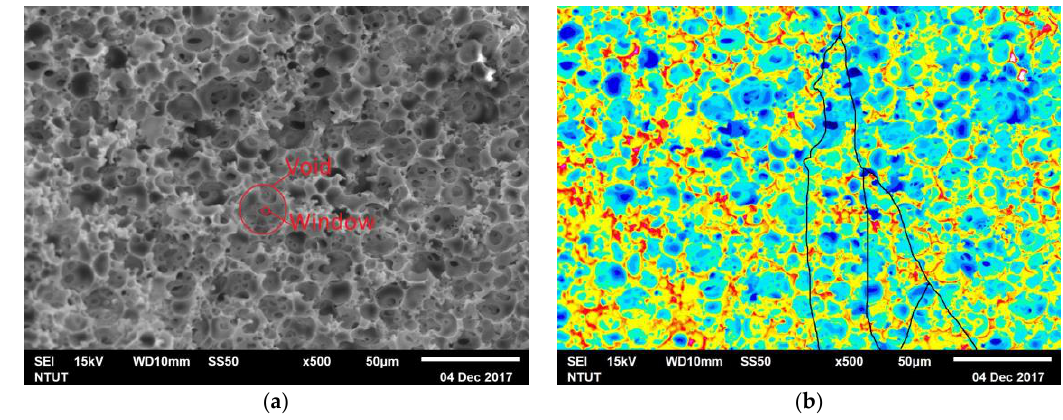
Figure 3. ( a ) SEM of PolyHIPE membrane (30 wt % St, 60 wt % EHA, and 10 wt % DVB) cross section. ( b ) Binarized SEM image by built-in SEM program, with black lines to indicate the L actual .